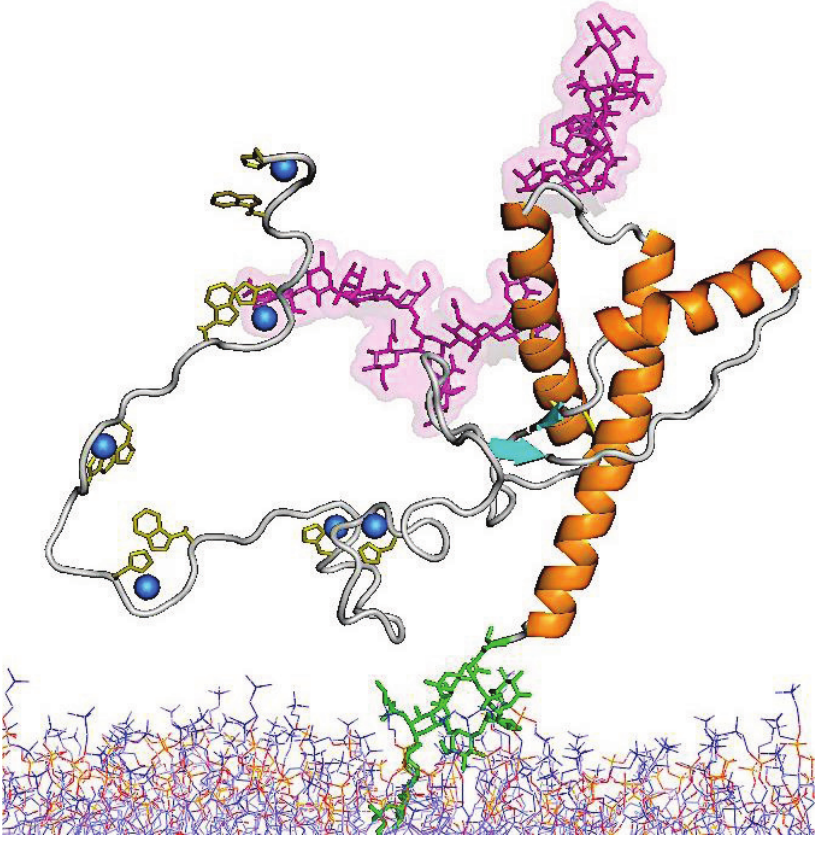
Figure 3. Schematic diagram of the structure of PrP C . The carbohydrate moieties that are linked to Asn 181 (down) and Asn 197 (up) are shown in pink. The C -terminal GPI-anchor is shown in green and is extending into the cell membrane in blue and red. OR residues in the N -terminal domain are known to bind copper ions (shown in blue). The composite data file for the structure [90,91] was kindly provided by Dr. Glenn Millhauser (University of California, Santa Cruz) and includes coordinates for the carbohydrates, the GPI-anchor, and the membrane that were provided by Dr. Valerie Daggett (University of Washington,